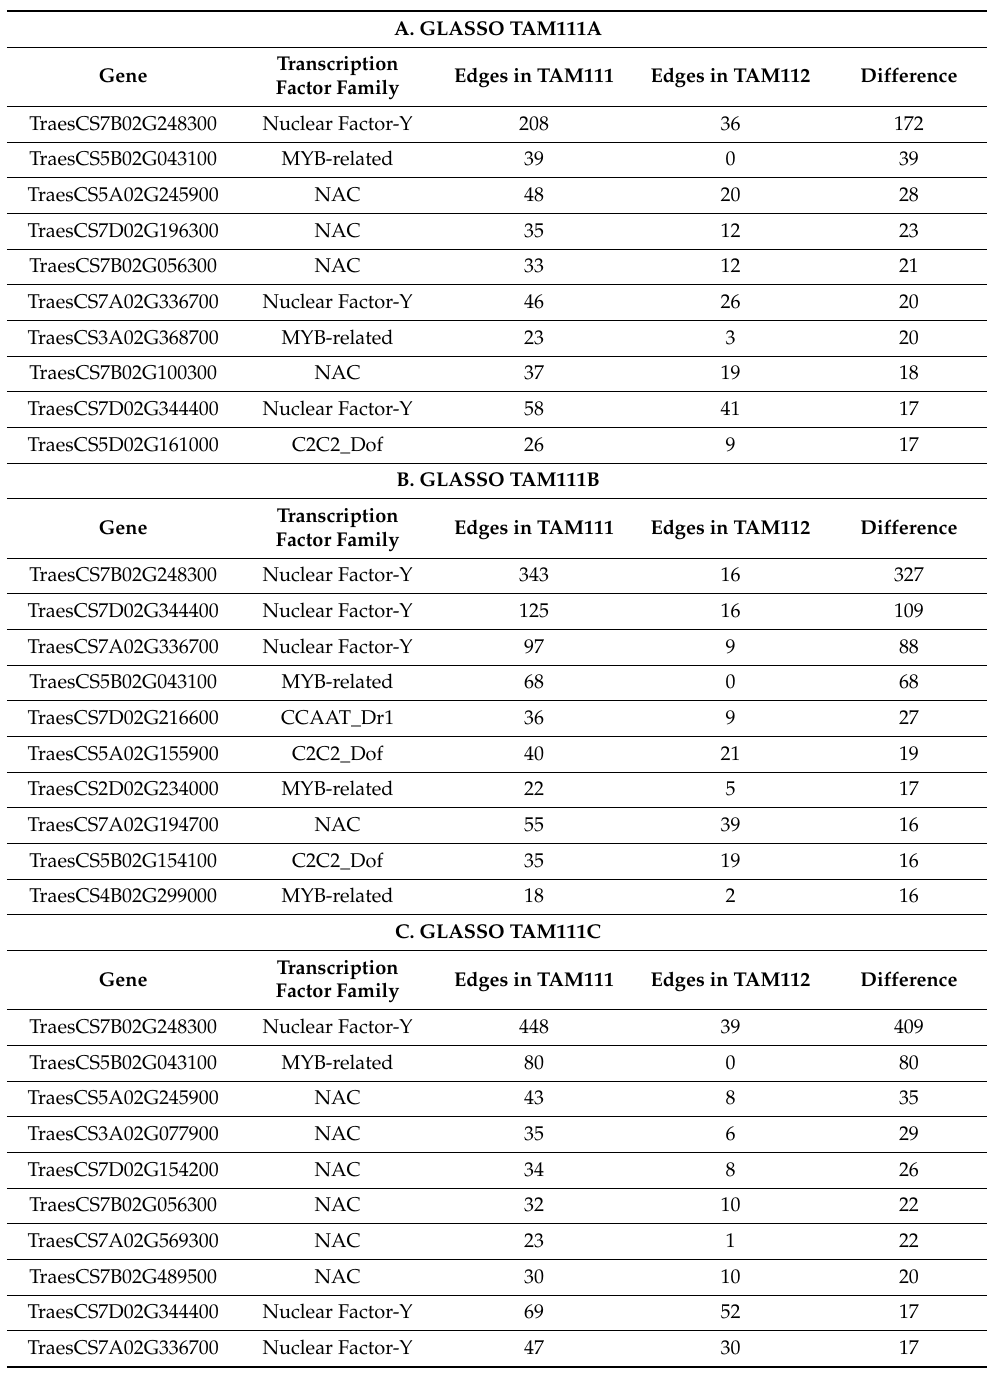
Table 2. Top 10 transcription factors identified from GLASSO using the module groups expressed higher in TAM111. ( A – C ) represents regions from TAM111 shown in Figure S4. Lists are sorted by the difference in the number of edges between the two